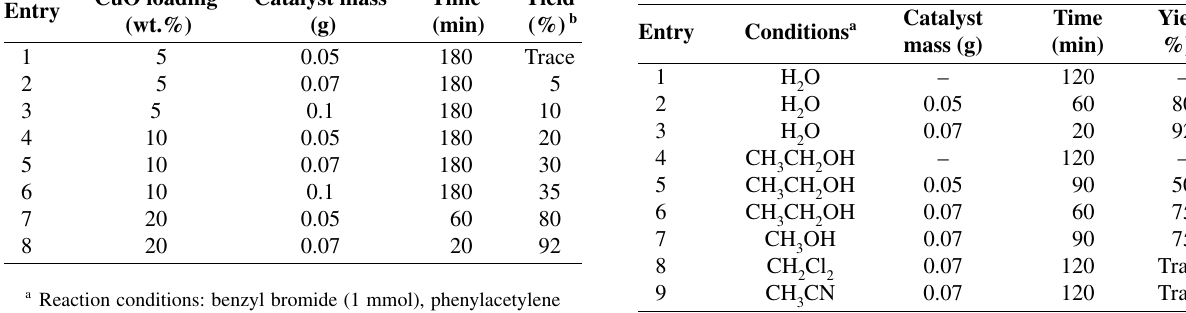
Table 2. Effect of CuO loading on the yield of 1,2,3-triazoles. a